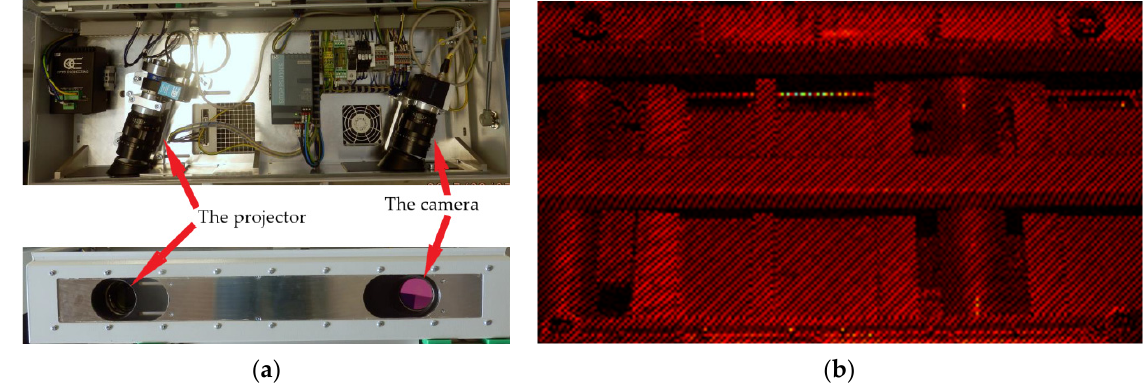
Figure 9. The case for a camera-projector subsystem ( a ), and scanned sector of the straightening machine with the billet ( b ).